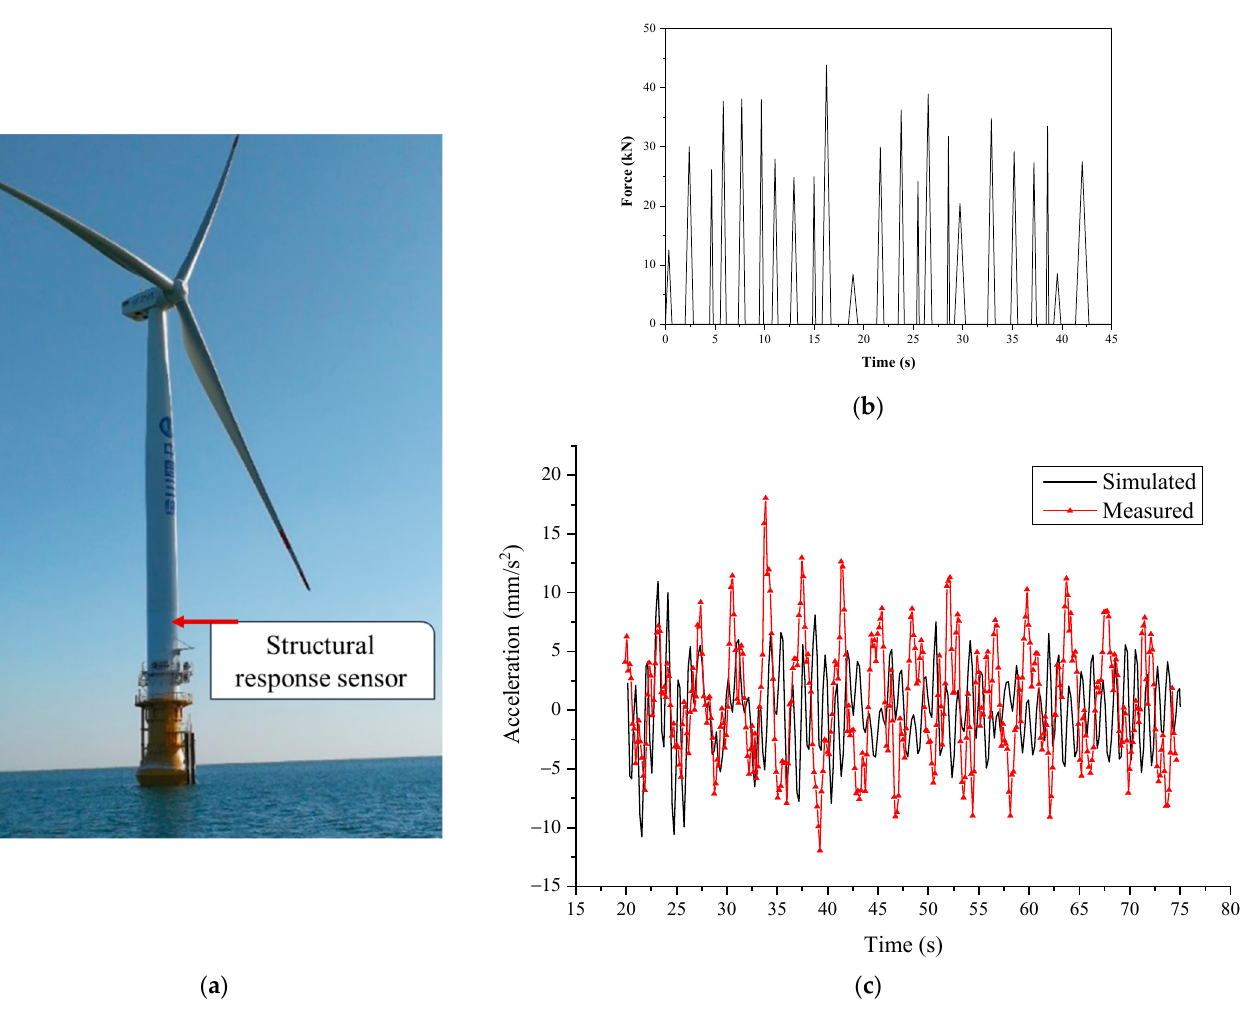
Figure 15. ( a ) Location point of the acceleration sensor; ( b ) time history curve of random ice forces under typical ice conditions; ( c ) simulated acceleration versus measured acceleration. Table 4. Acceleration and period comparison between simulation and measurement.